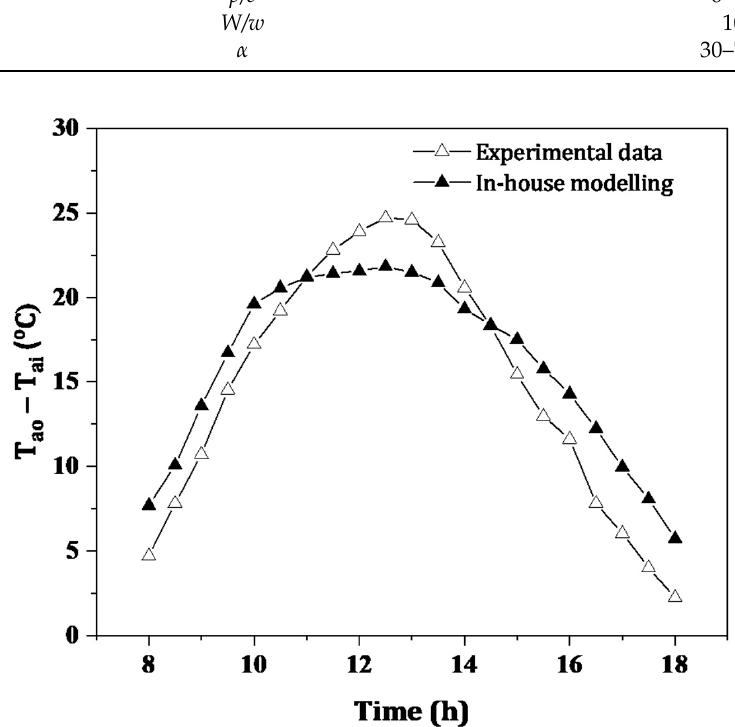
Figure 3. Temperature difference across a smooth SAH ( T ao − T ai ) versus daytime hours using our in-house model predictions and experimental data inferred from [25].